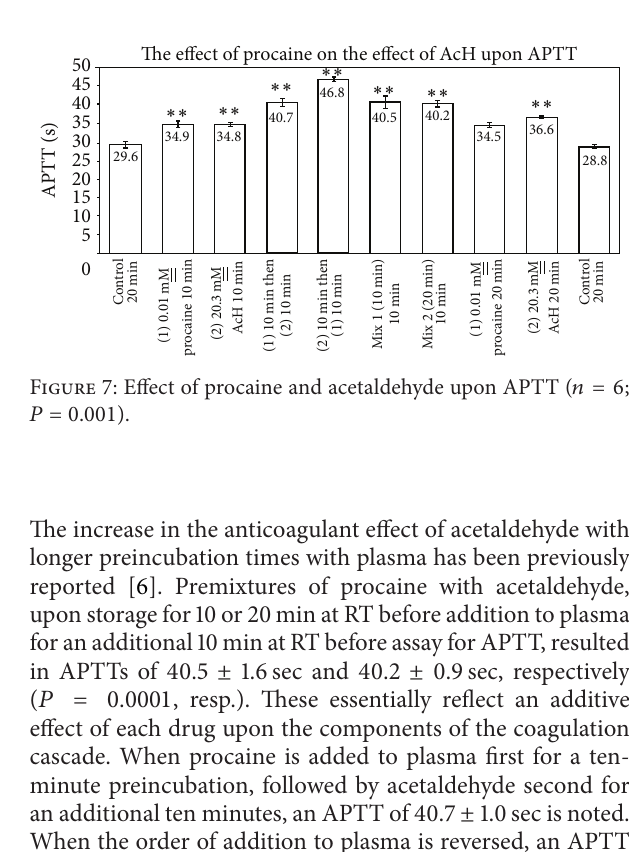
Figure 6: Effect of isoproterenol and acetaldehyde on APTT ( 𝑛 = 6 ; 𝑃 = 0.01 ).